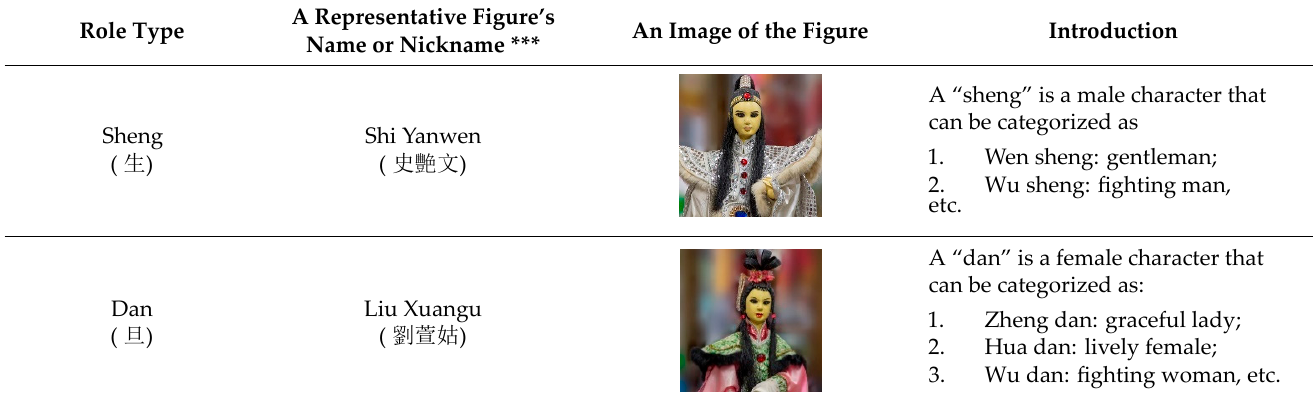
Figure 4. The research flowchart of this study, including the adopted research methods as well as the confirmation of the research theme and the drawing of conclusions and suggestions for future researches. Table 1. Classification of the roles of an example of traditional puppet‑show dramas entitled “The Great Confucian Hero of Yunzhou” (note: this hero is the representative figure of the role of Sheng, named Shi Yanwen, shown below).